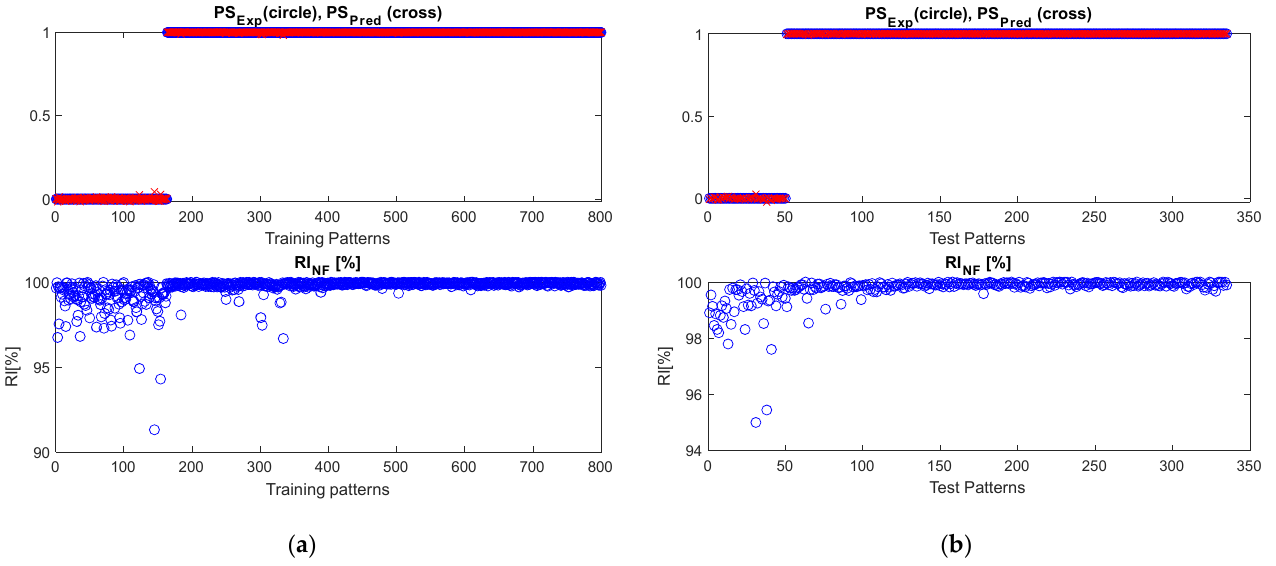
Figure 5. The behavior of the NF inference system for postural status detection. Both ( a ) training and ( b ) test datasets are shown.